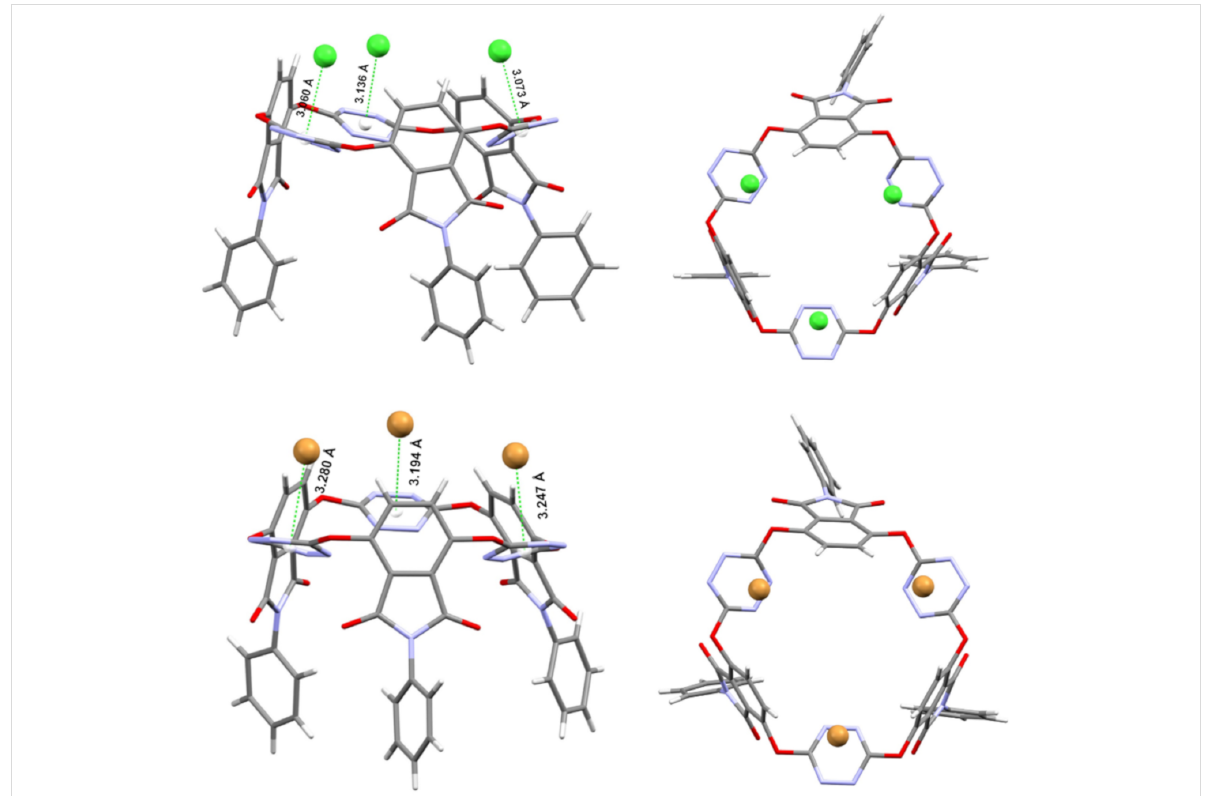
Figure 4: X-ray molecular structures of complexes ( n -Bu 4 NCl) 3 - 3a (1913908) (top) and ( n -Bu 4 NBr) 3 - 3a (1913909) (bottom) with side (left) and top (right) views. Cations and solvent molecules are omitted for